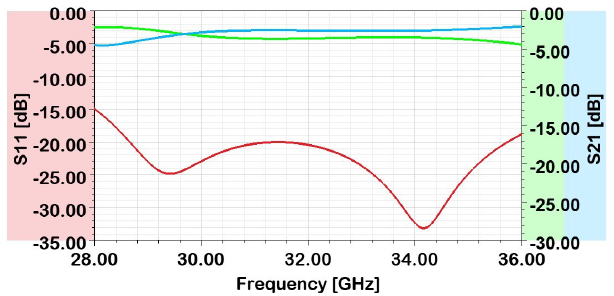
FIGURE 4. S 11 (red) and S 21 (green, blue) of the Polarizer